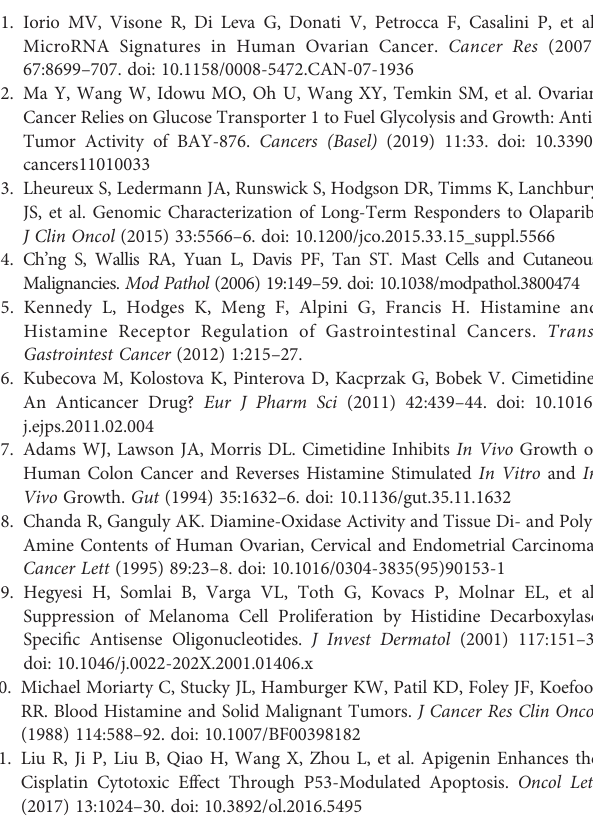
Supplementary Figure 2 | The proliferation rate of Anglne cell after HA and APG treatment. * P < 0.05 (Compared to untreated Anglne cell group); # P < 0.05 (compared with the HA-treated group).